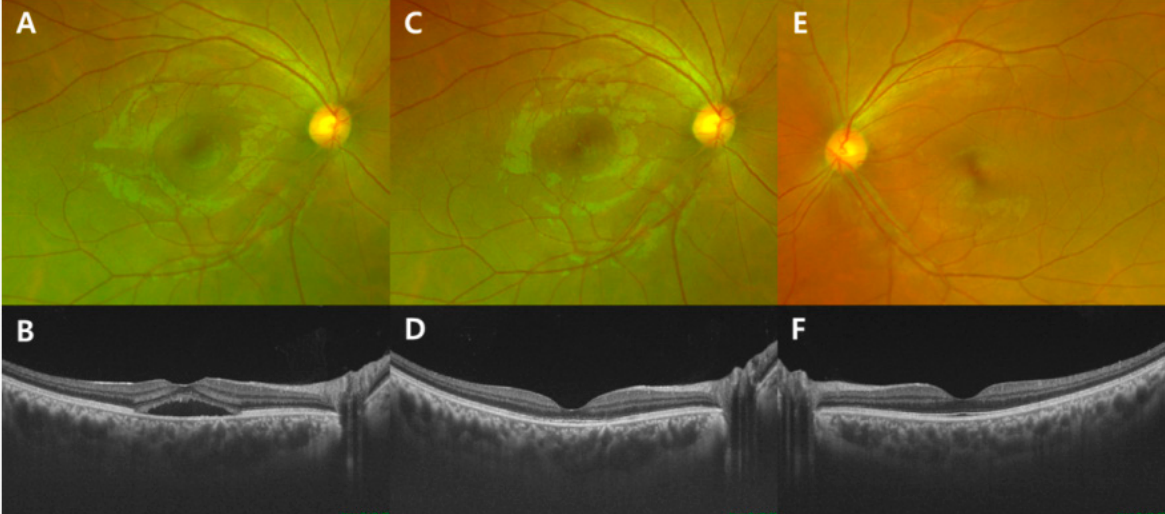
Figure 1. Fundus photography and optical coherence tomography (OCT) images in a 34-year-old man with acute central serous chorioretinopathy (CSC) showing serous retinal detachment (SRD) at the initial examination (( A ) fundus photography; ( B ) OCT image), spontaneous resolution of subretinal fluid (SRF) after 1 month (( C ) fundus photography; ( D ) OCT image)), and unaffected fellow eye (( E ) fundus photography; ( F ) OCT image). The mean logarithm of the minimal angle of resolution (logMAR) best-corrected visual acuity was 0.00 (Snellen equivalent: 20/20) at the initial SRD phase and 0.00 (20/20) after spontaneous SRF resolution. Visual acuity in the fellow eye was 0.00 (20/20).